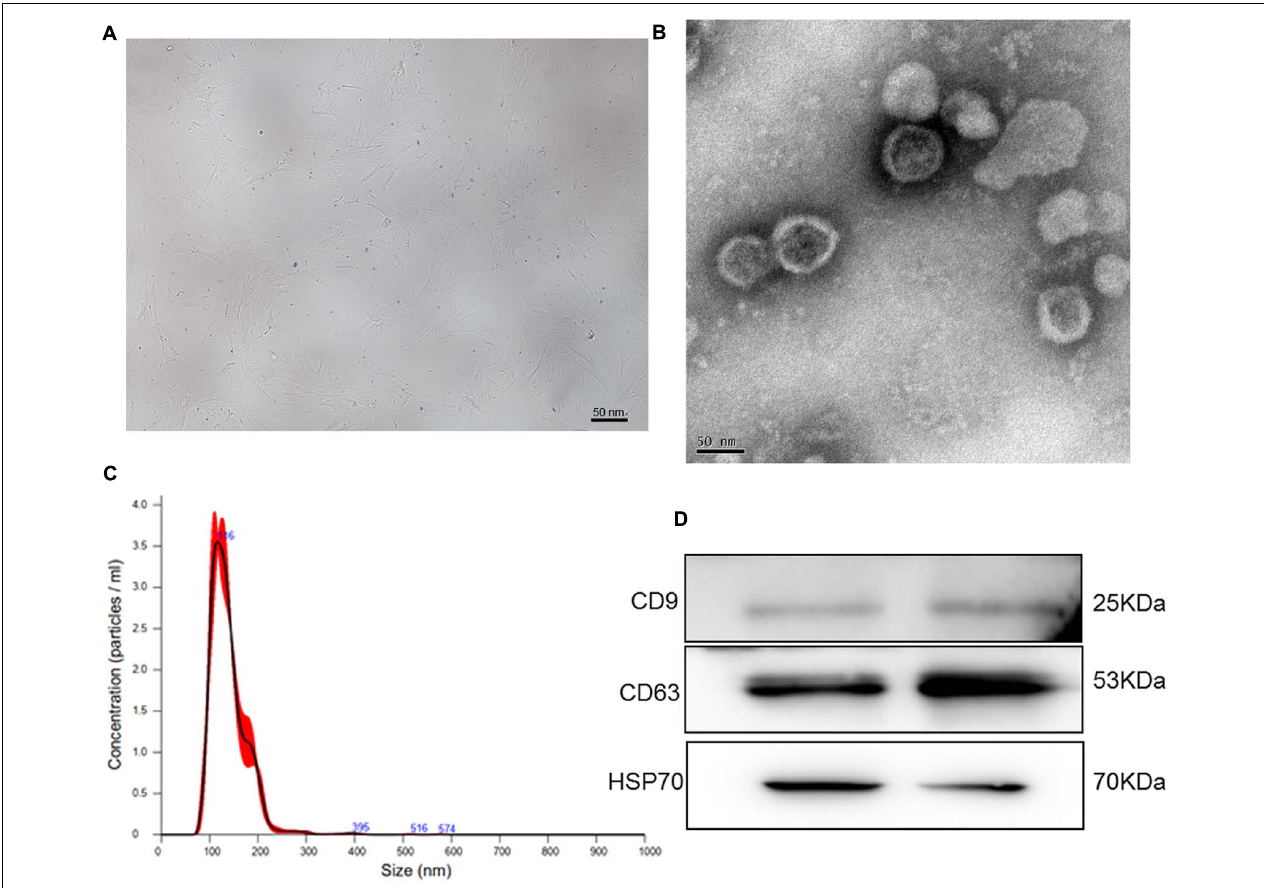
FIGURE 1 | (A) The morphology of human bone marrow mesenchymal stem cells (BMSCs). (B) Transmission electron microscopy image of exosomes isolated from human BMSCs. (C) The size distribution of exosomes determined by nanoparticle tracking analysis. (D) The images of exosome-specific CD9, CD63, and HSP70 proteins examined by western